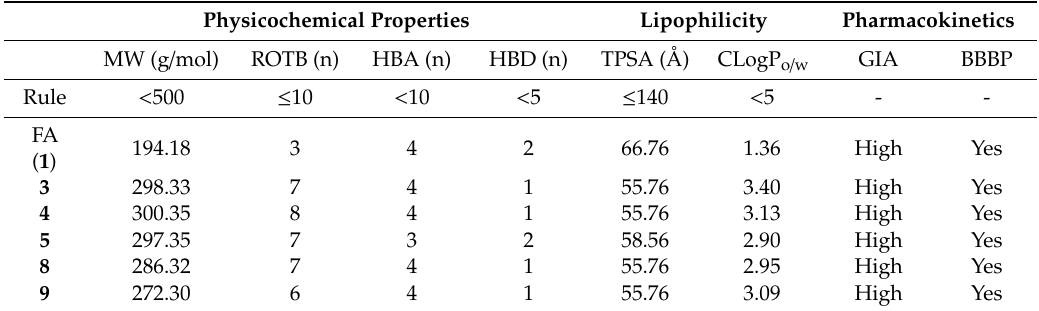
Table 2. Absorption, distribution, metabolism, and excretion (ADME) profile of FA ( 1 ) acid and its related analogues.